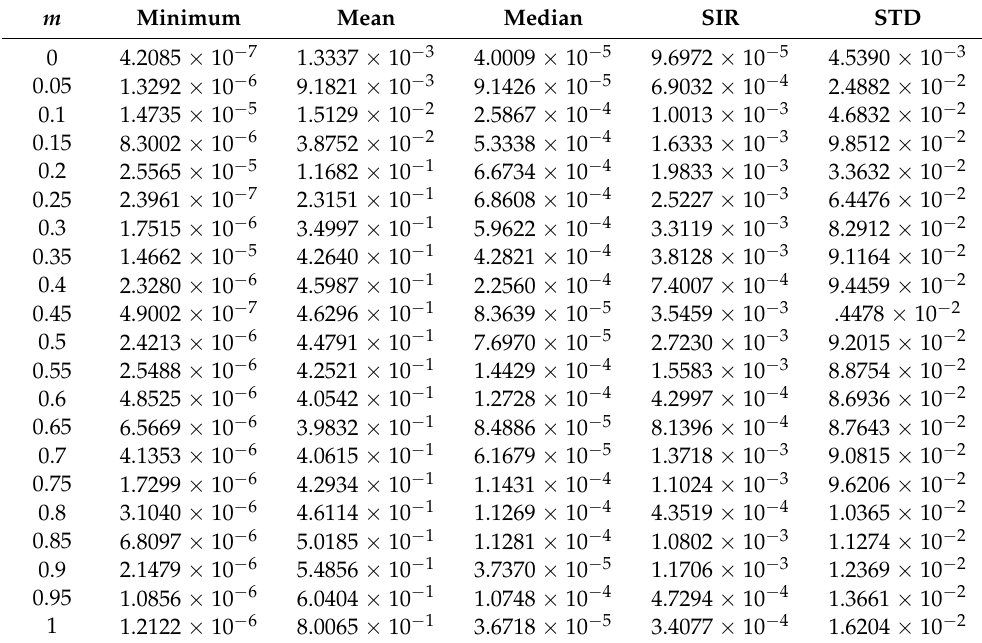
Table 3. Statistical measures for the stochastic operators based on case 3 for the NSPM-SK. m